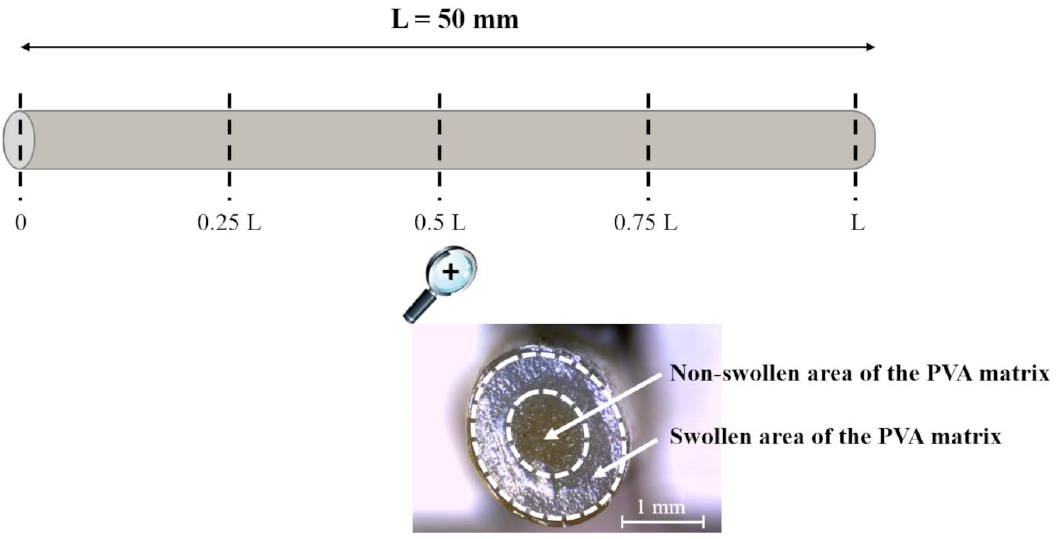
Figure 3. Outline of the different positions where the swollen I-shaped samples were cut and photograph of a cross-section with details relevant to the different areas measured.